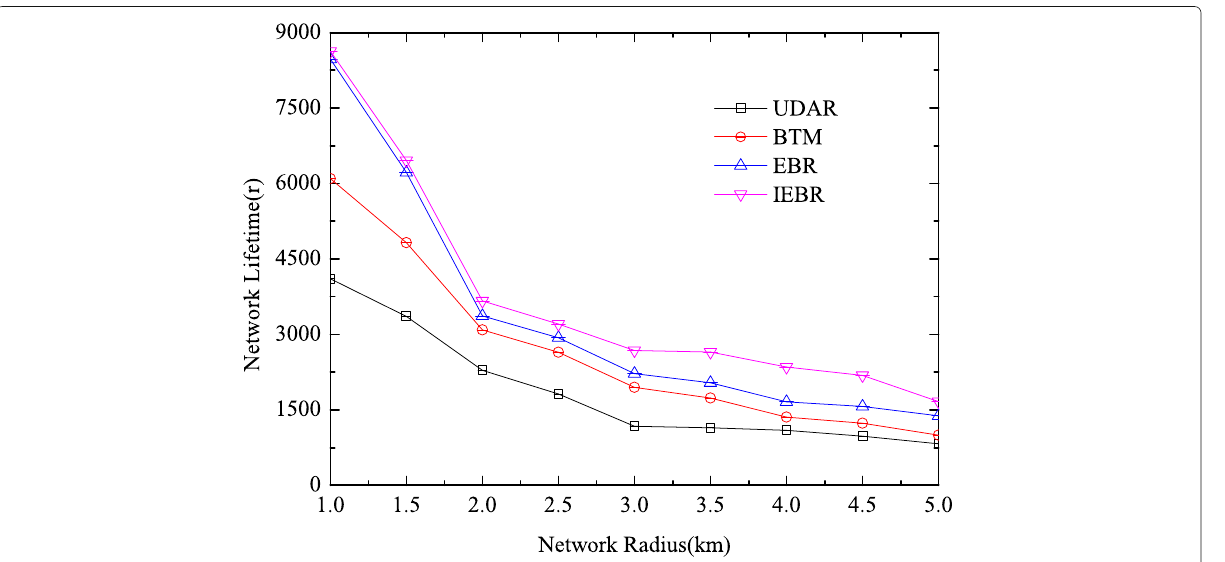
Fig. 8 The network lifetimes with different network radiuses